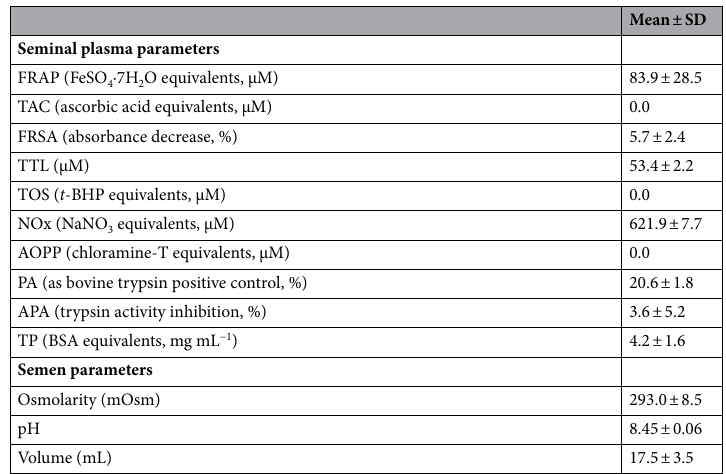
Table 2. Mean (± SD) values of seminal plasma oxidative profile and proteolysis regulator parameters, and semen parameters in the azoospermic donkey stallion. Semen collections (n = 2). FRAP: ferric reducing ability of plasma; TAC: total antioxidant capacity; FRSA: free radical scavenging activity; TTL: total thiol levels; TOS: total oxidant status; NOx: nitric oxide metabolites; AOPP: advanced oxidation protein products; PA: protease activity; APA: antiprotease activity; TP: total protein.